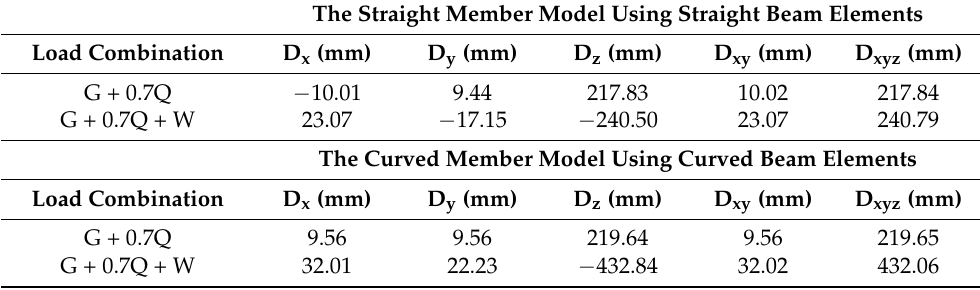
Table 11. Maximum structural displacement under serviceability limit state (non-linear static